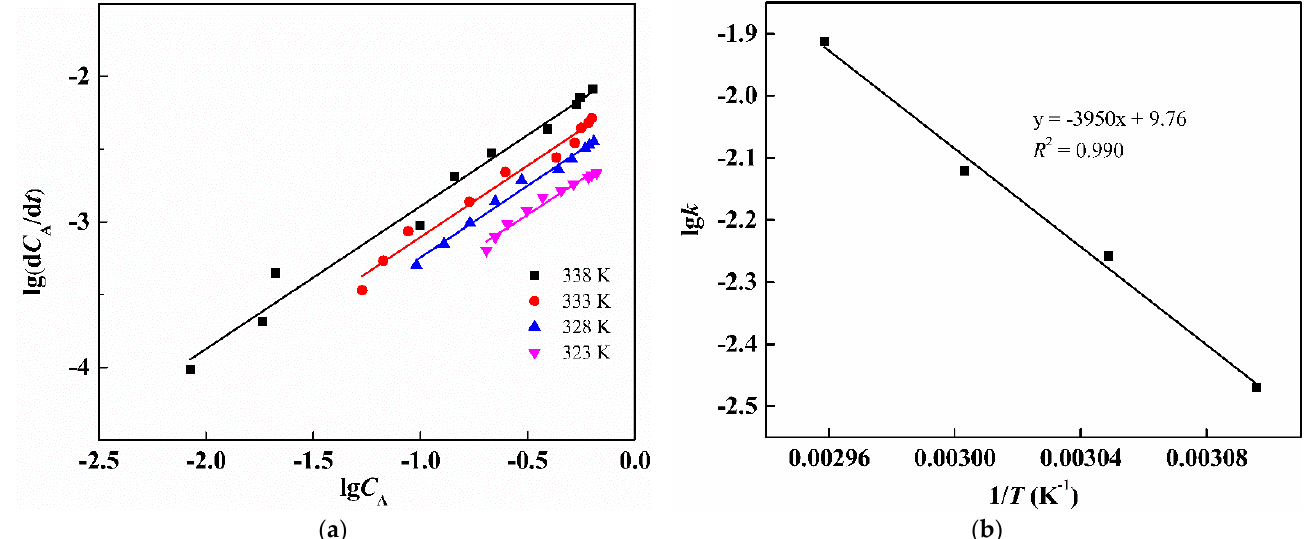
Figure 6. Plots of ( a ) lg( - d C A /dt) vs. lg C A and ( b ) lg k vs. 1/ T for the transesterification. Table 3. The fitting results of lg( - d C A / d t ) vs. lg C A . Temperature (K) Slope Intercept R 2 323 0.961 − 2.47